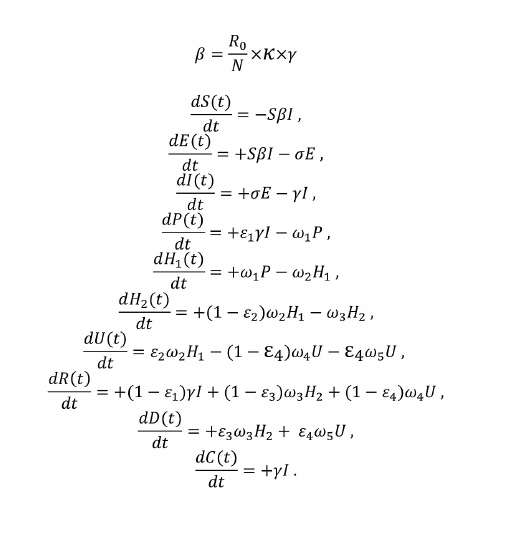
Figure 2: Equations used in the CZ